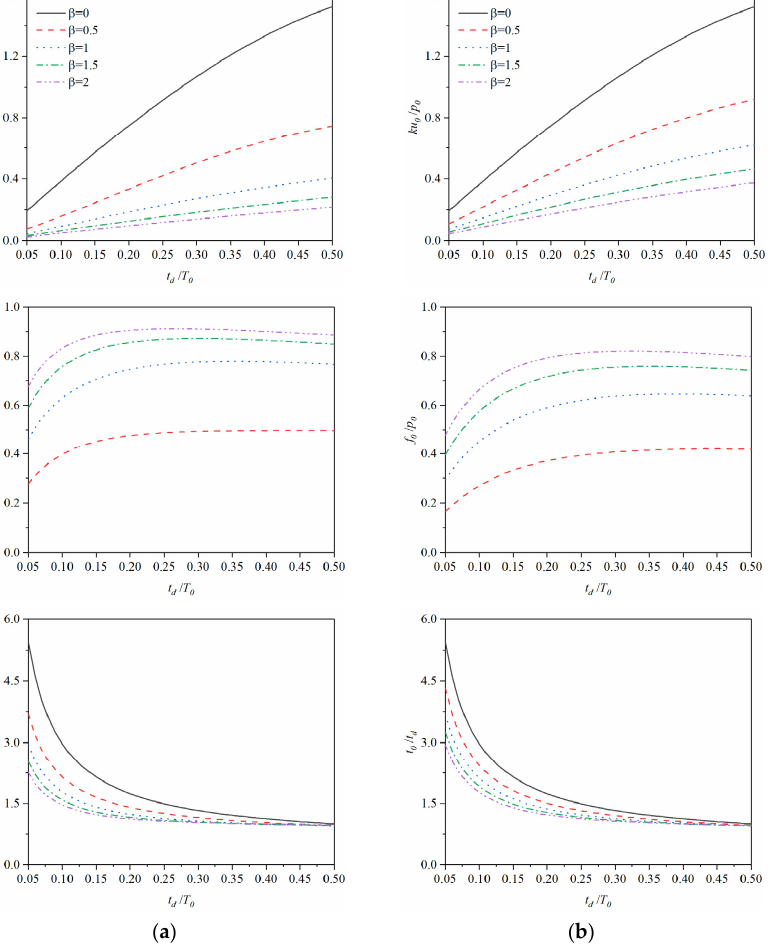
Figure 11. Maximum responses of the SDOF system with various ECDs under half-cycle sine shock excitation: ( a ) 𝛾 = 0.5 ; and ( b ) 𝛾 = 1 .